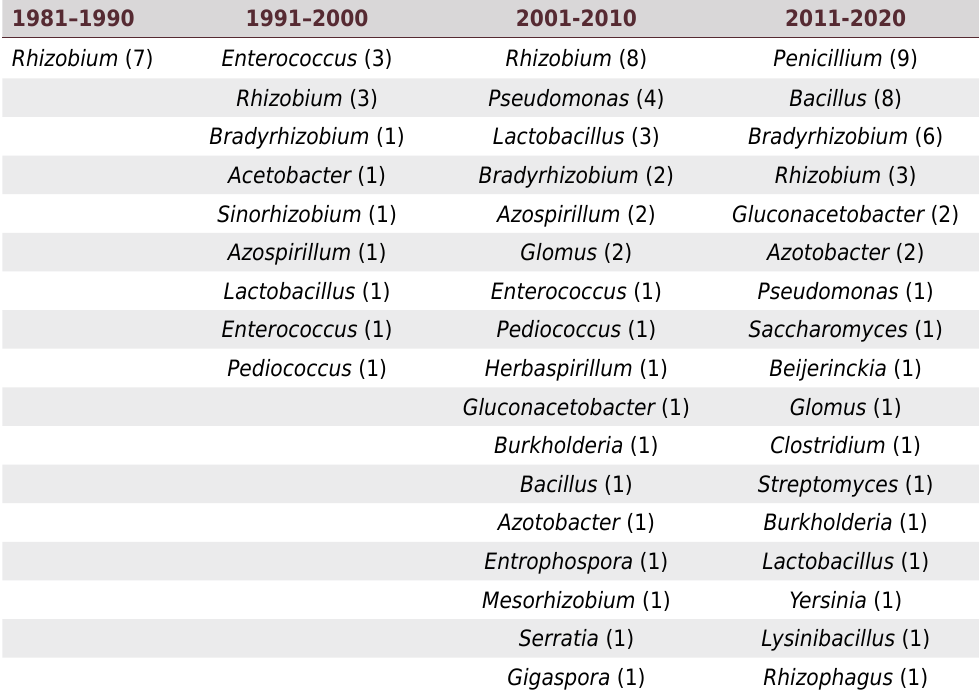
Table 4. Genera of microorganisms used in the production of inoculants for agriculture from 1981 to 2020